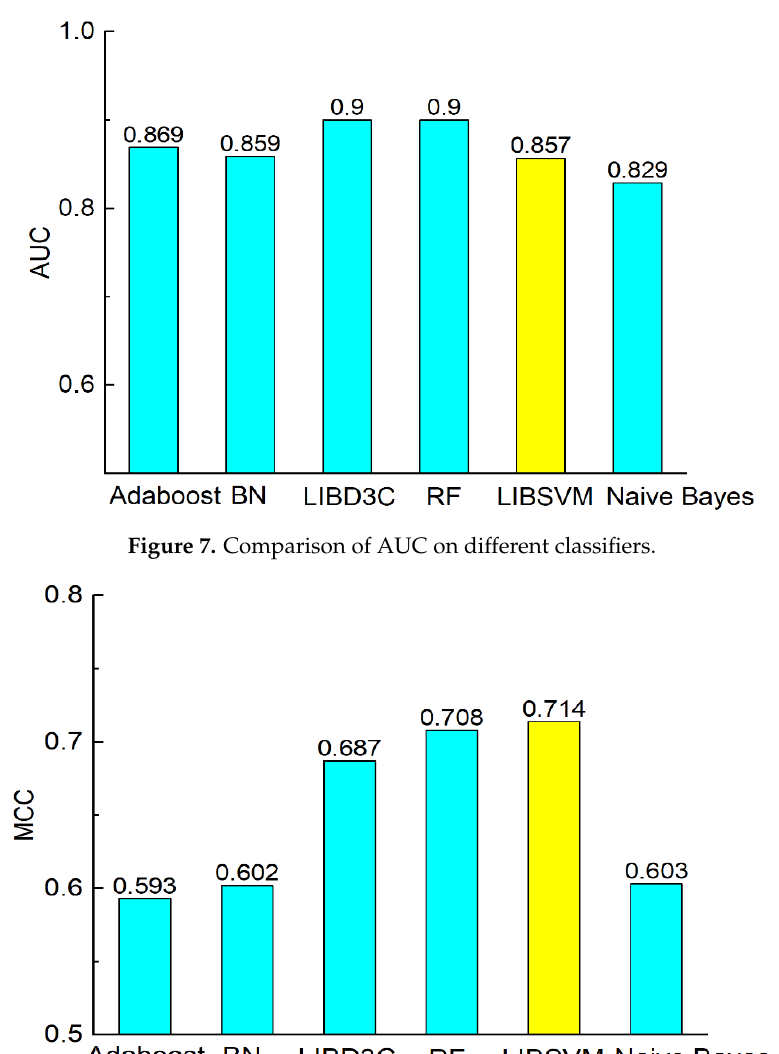
Molecules 2018 , 23 , x FOR PEER REVIEW Figure 6. Comparison of F-measure on different classifiers. Figure 6. Comparison of F-measure on different classifiers.